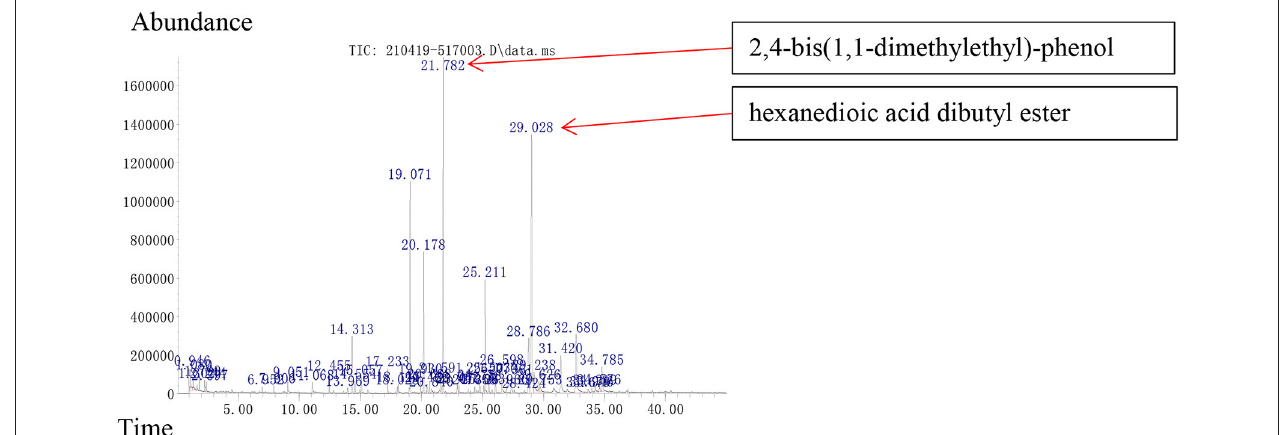
FIGURE 5 | Volatile organic compounds of strain TOR3209 using GC-MS. The samples were incubated in bottle containing LB agar for 3 days. 2,4-bis(1,1-dimethylethyl)-phenol and hexanedioic acid dibutyl ester were detected.